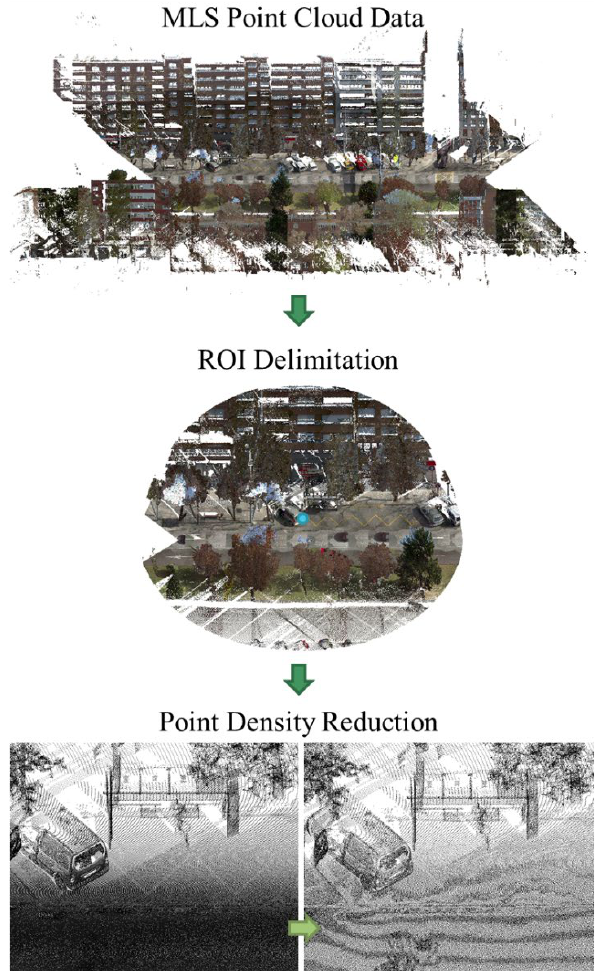
Figure 2. Workflow of the initial MLS point cloud processing. The blue dot indicates the centre of the